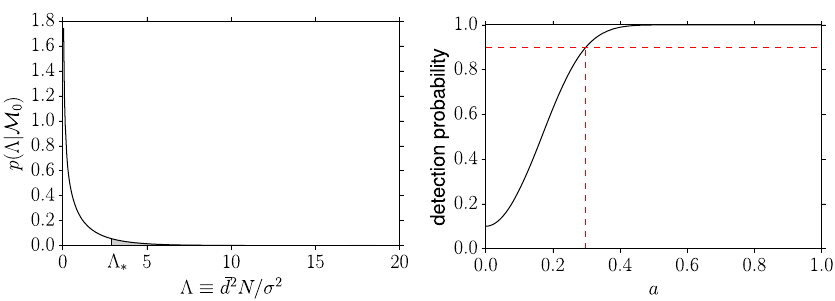
Fig.12 Left panel Probabilitydistribution forthe frequentist detection statistic Λ forthe noise-onlymodel. The threshold value of the statistic for 10% false alarm probability is Λ ∗ = 2 . 9. Right panel Detection probabilityasafunctionoftheamplitude a .Thevalueoftheamplitudeneededfor90%confidencedetection probability with 10% false alarm probability is a 90% , DP = 0 . 30